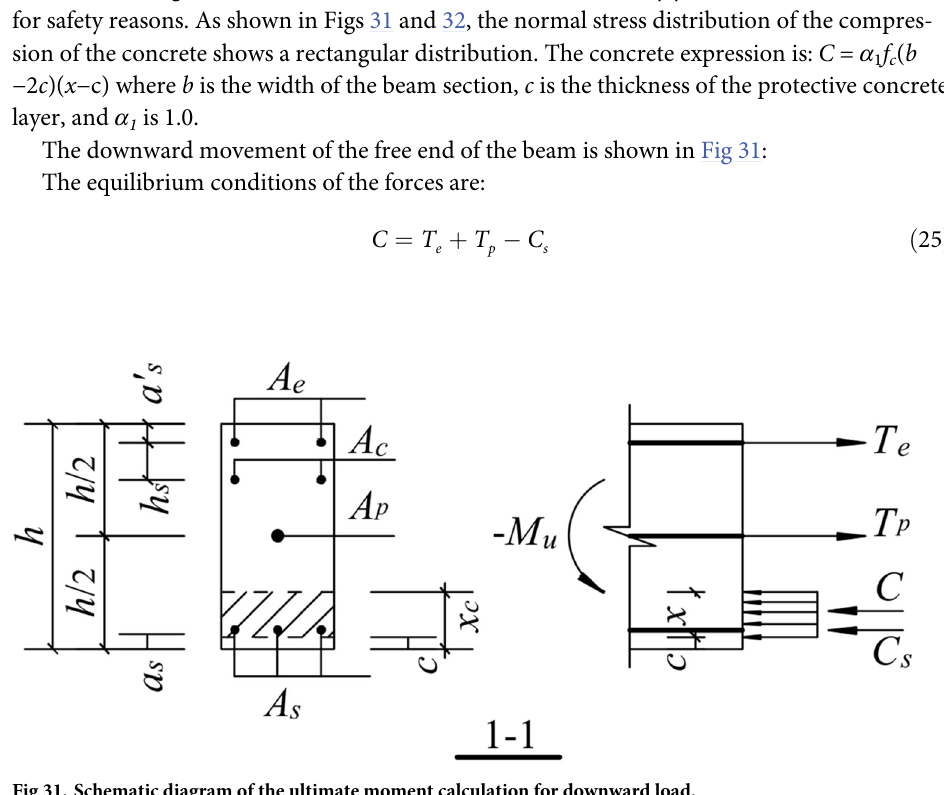
Fig 31. Schematic diagram of the ultimate moment calculation for downward